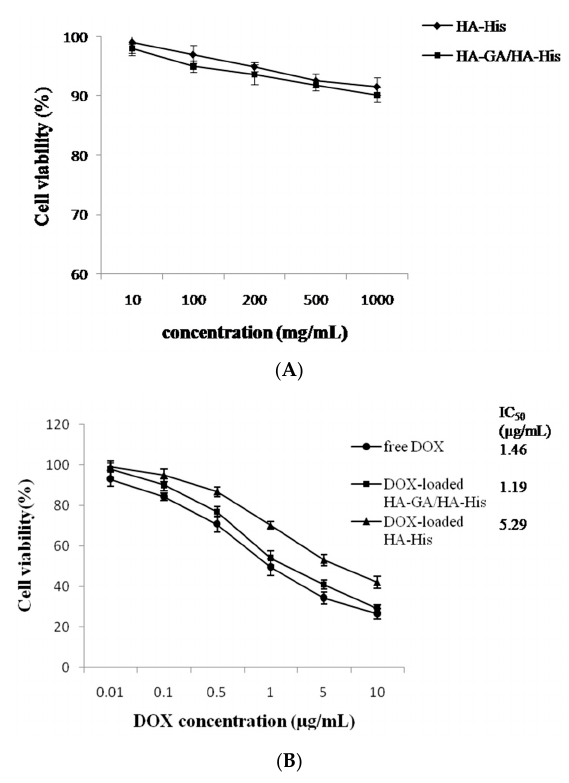
Figure 7. Viability of HepG2 cells after respective treatment with blank micelles ( A ) and free